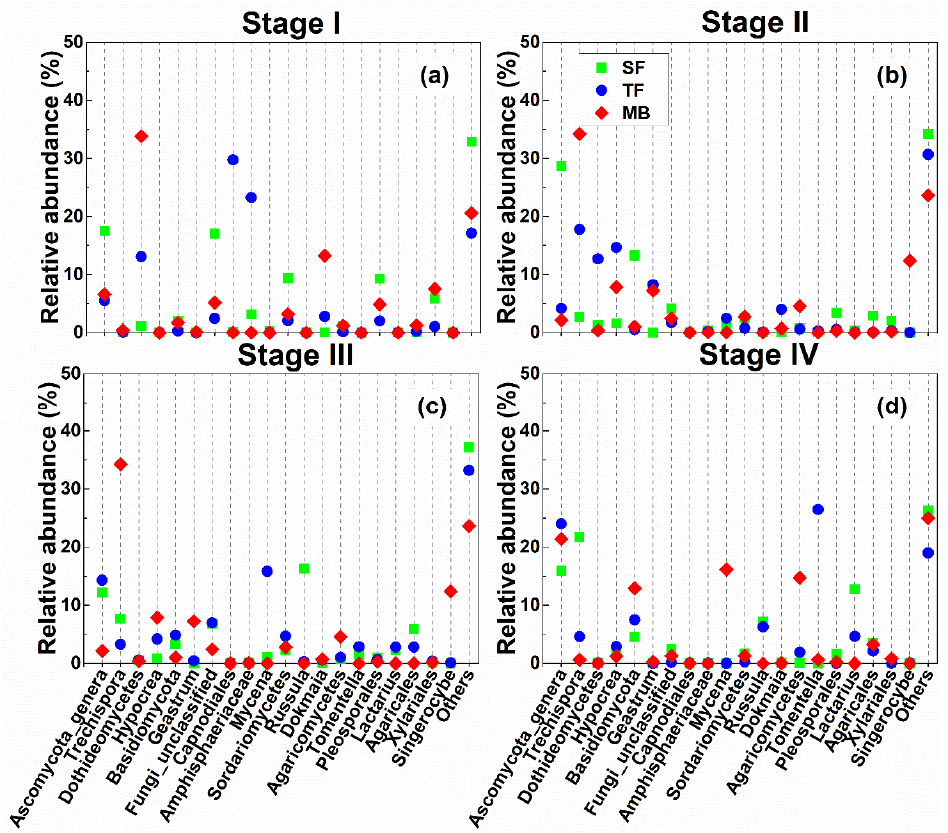
Figure 5. Relative abundances of fungal OTU clusters at the genus level from the four litter decomposition stages (I, II, III, and IV) in the three forest types. ( a – d ) a–d, in turn, is the